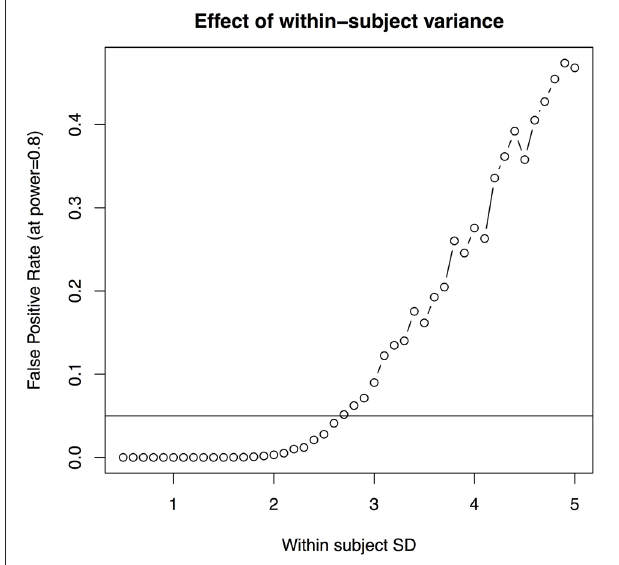
FIGURE 5 | The effect of within subject variability on the ability to estimate group differences. This is estimated based on 10 subjects per group, four scans per subject.